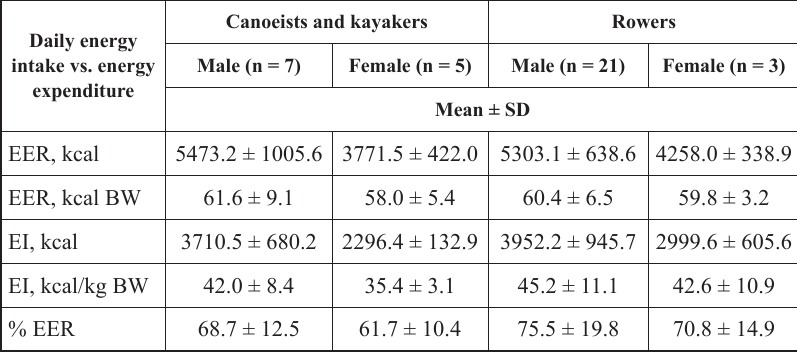
Note. BMI – Body Mass